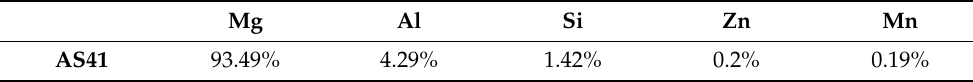
Figure 1. ( a ) SEM morphology of AS41 powders, ( b ) the laser scanning strategy with a hatch rotation of 67 ◦ of SLM process. Table 1. Chemical compositions of AS41 powders (wt.%).